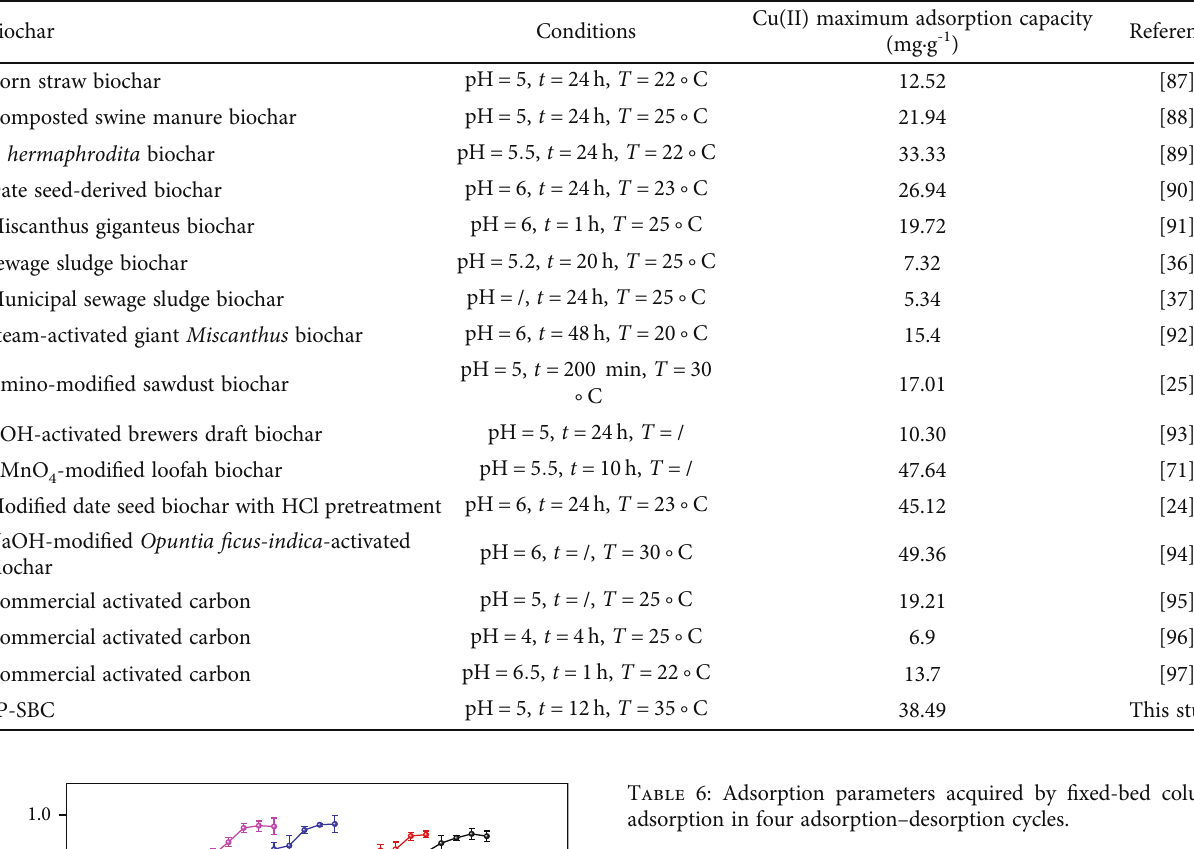
Table 5: Cu(II)-adsorption capacities of di ff erent biochars.